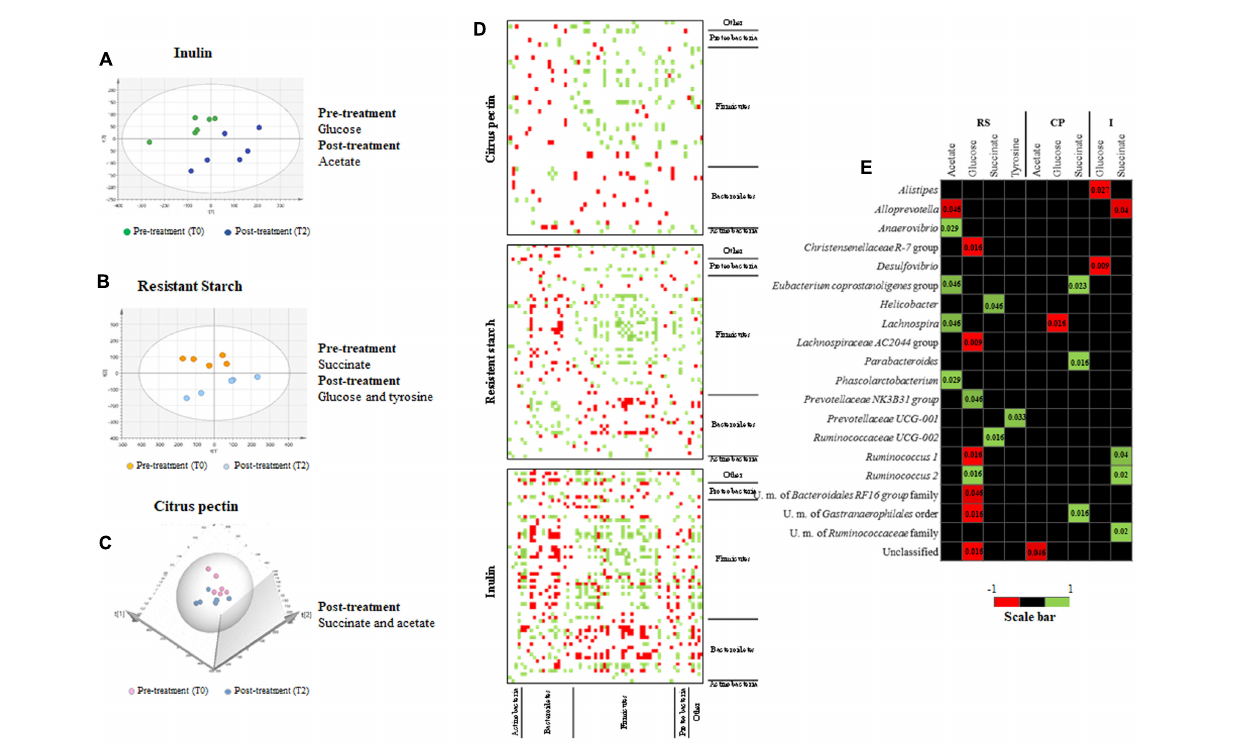
FIGURE 4 | Metabolomics profile of dietary fiber intervention on rats. (A–C) Show the PCA score plots of rat fecal samples, respectively, for I ( R 2 ( cum ) = 0.57, Q